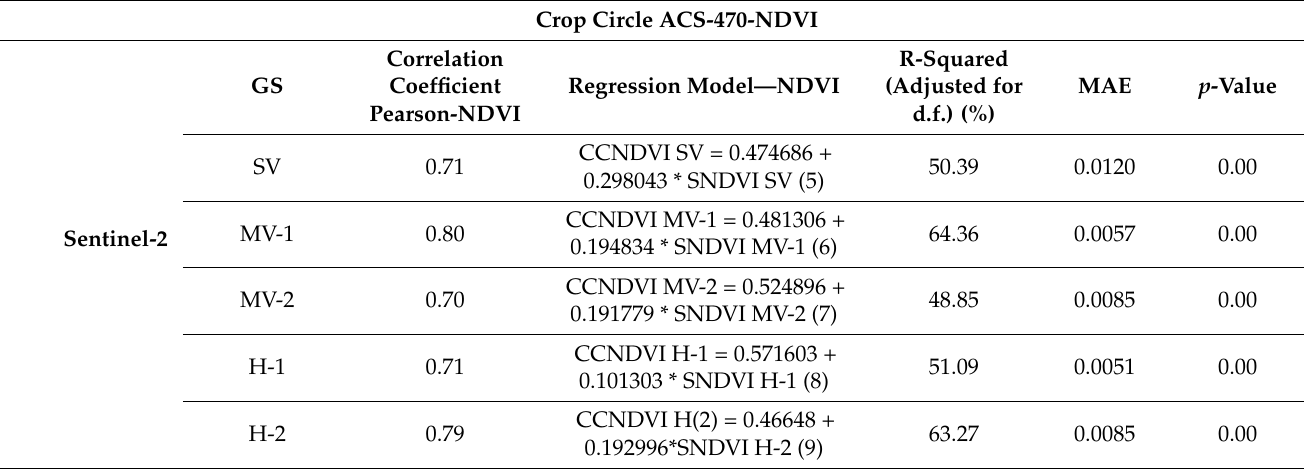
Figure 6. Regressions between NDVI and NDRE derived from Sentinel-2 images and Crop Circle sensor. Green lines show confidence, while and the gray lines show the prediction limits. Table 4. Regression models of proximal and satellite-derived